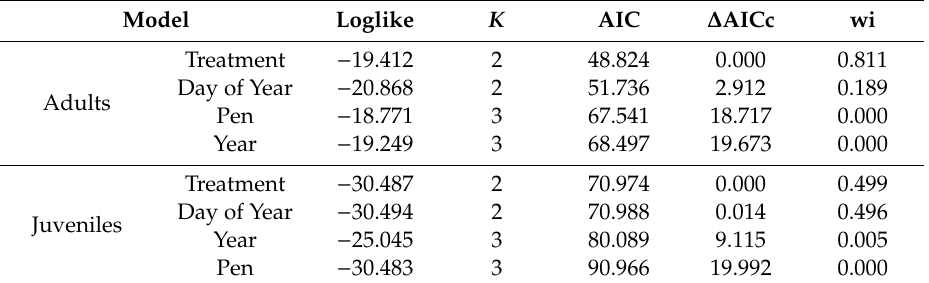
Table 2. Comparison of four candidate models examining e ff ect of variables on post-release survival of resident and translocated Texas horned lizards ( Phrynosoma cornutum ).